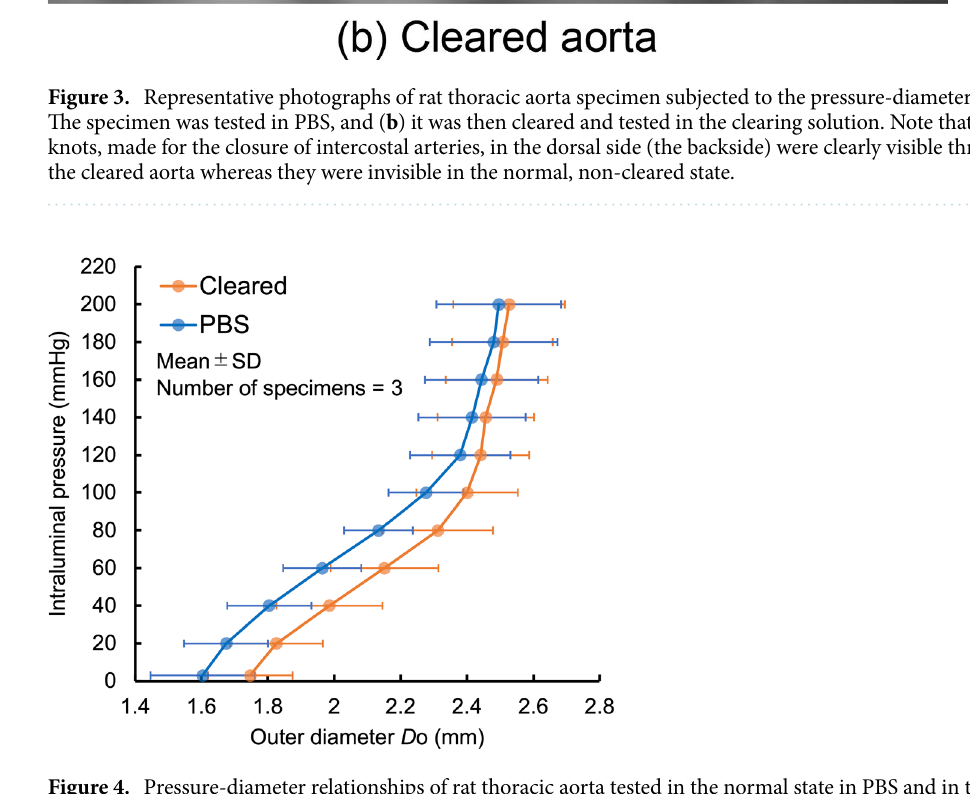
Figure 4. Pressure-diameter relationships of rat thoracic aorta tested in the normal state in PBS and in the cleared state in the clearing